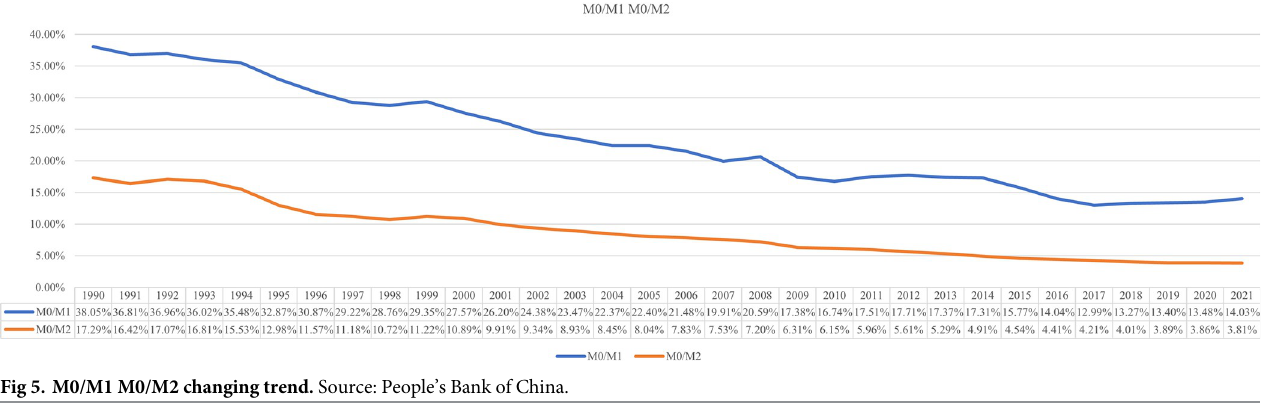
Fig 5. M0/M1 M0/M2 changing trend. Source: People’s Bank of China.